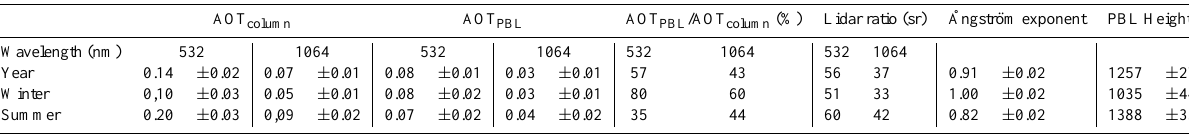
Table 2. Annual, winter and summer means and errorbars (computed with the ML estimation) of the columnar AOT, the PBL AOT, the ratio AOT PBL , the lidar ratio, the backscatter-related ˚Angstr¨om exponent and the PBL height. AOT column AOT column AOT